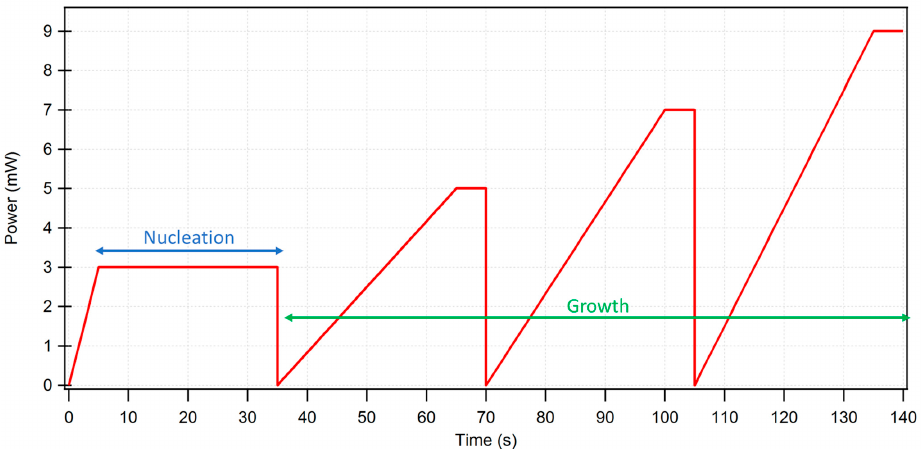
Figure 2. Heating schedule for dots created with a ‘ring’ procedure. The glass is illuminated with a circular beam of uniform intensity during the nucleation stage, designated in the figure, followed by 3 growth stages using rings of larger diameters. The power is increased to maintain a constant power density throughout crystallization.